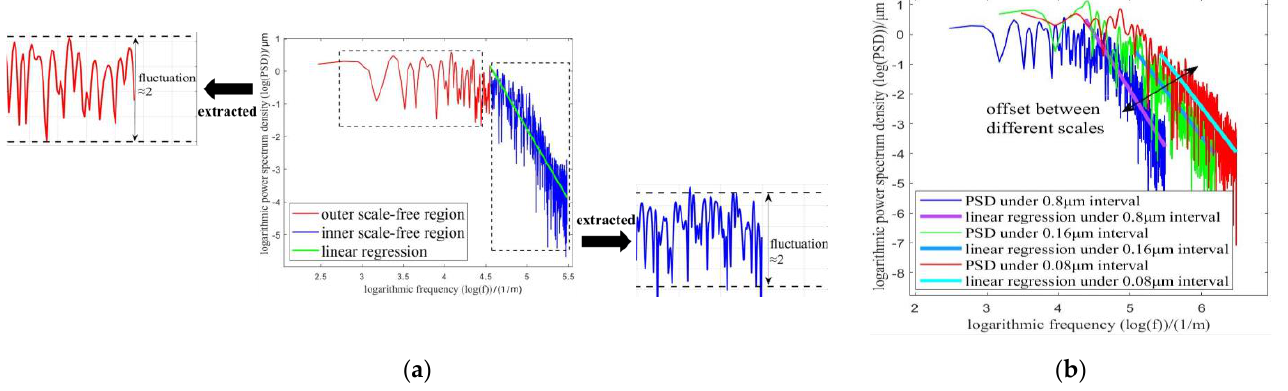
Figure 1. The basic concepts of fractals and scale dependence. ( a ) the scale-free region; ( b ) the scale-dependence phenomenon.